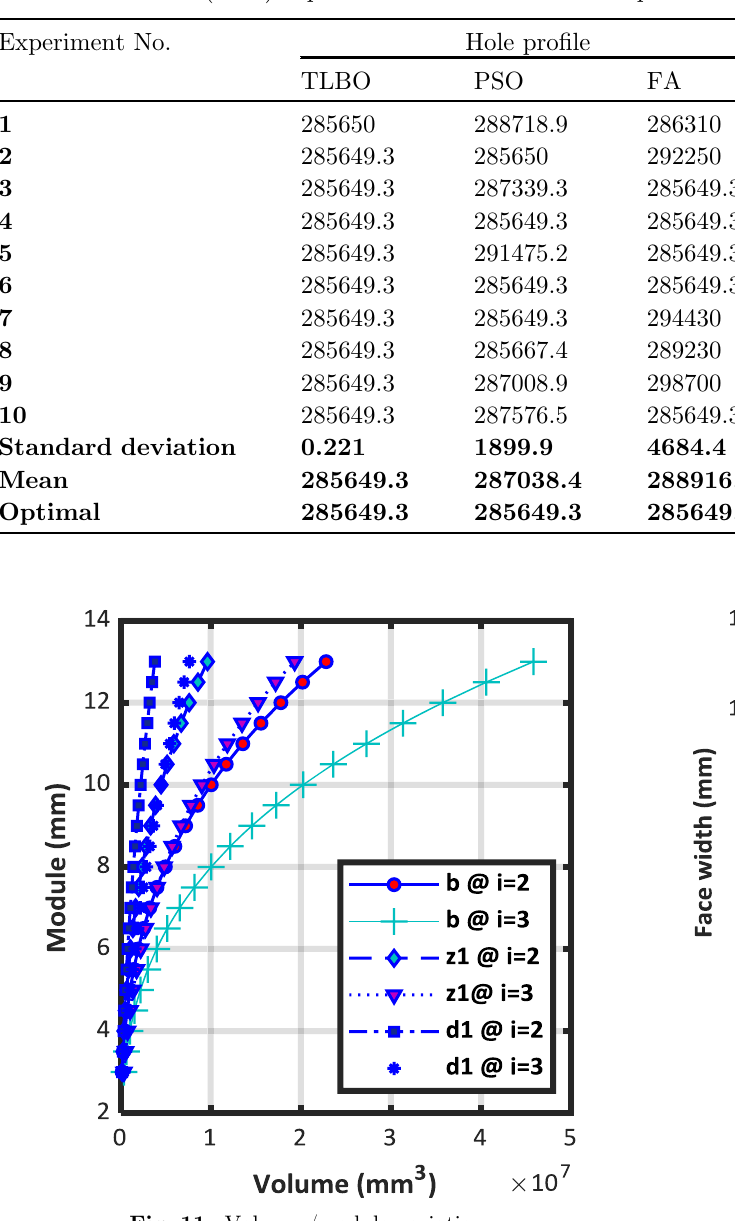
Fig. 11. Volume /module